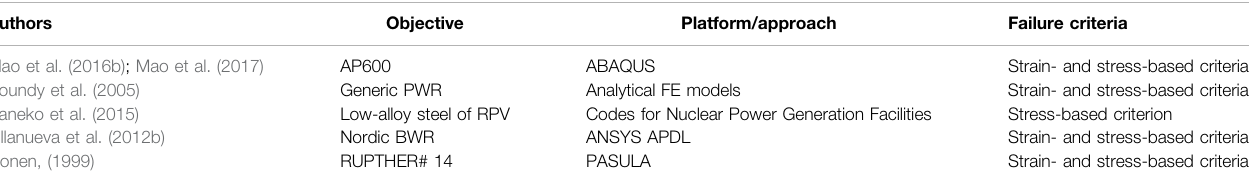
TABLE 1 | Examples from the literature (Ikonen, 1999; Koundy et al., 2005; Villanueva et al., 2012b; Kaneko et al., 2015; Mao et al., 2016b; Mao et al., 2017) of strain- and stress-based failure criteria used in structural analysis of RPVs. Authors